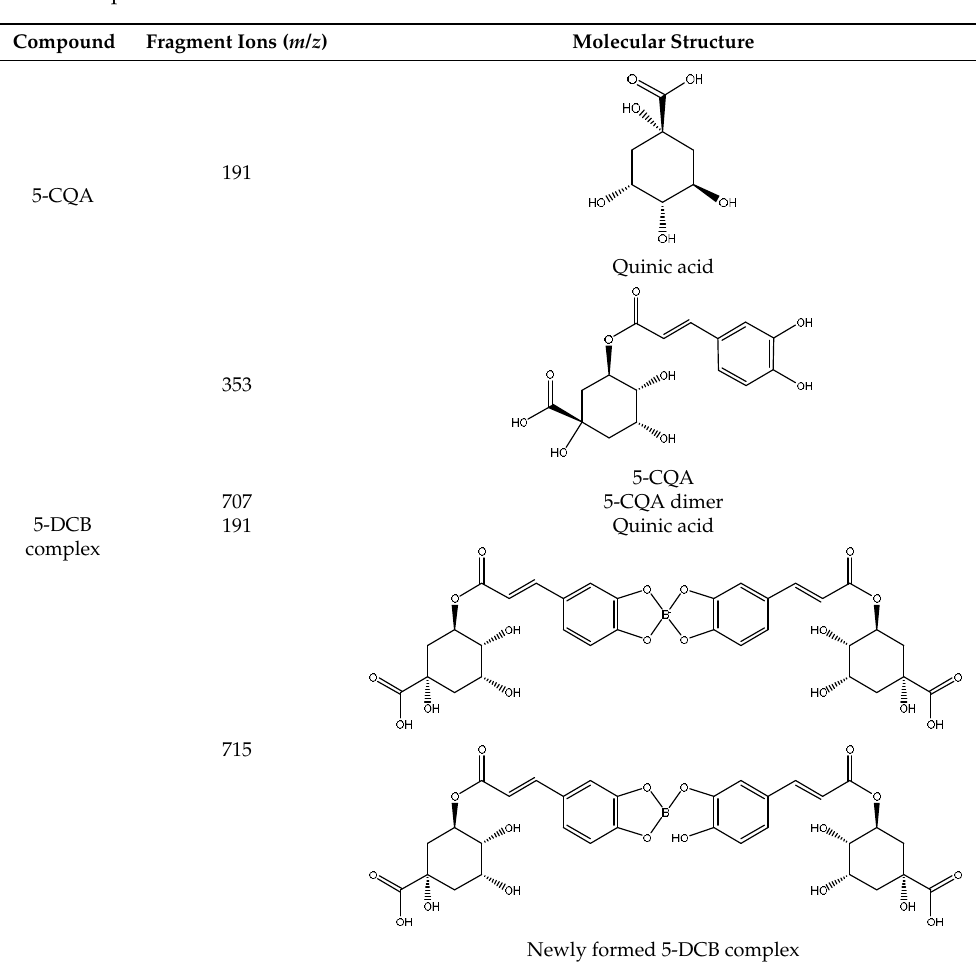
Table 1. Fragment ions ( m / z ) found in the mass spectra and supposed molecular structure for 5-DCB complex.